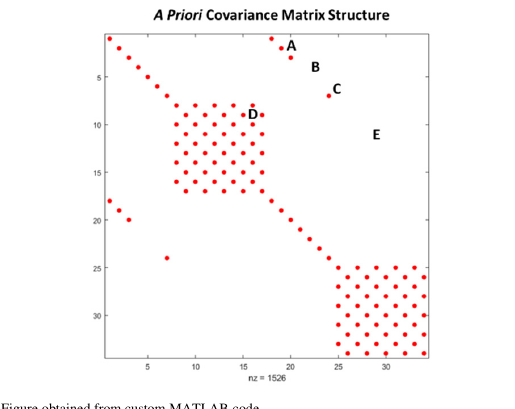
Figure obtained from custom MATLAB code Figure 5. Full a priori covariance matrix associated with